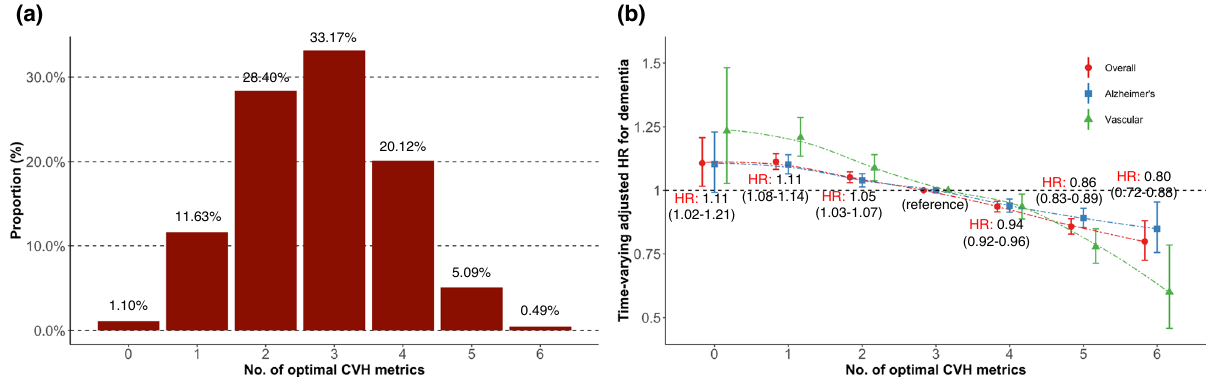
Figure 2. Plots of time-varying HRs for the association of the number of optimal CVH metrics with the risk of dementia. ( A ) The proportion of participants according to the number of optimal CVH metrics. ( B ) Time-varying HRs plot according to the number of optimal CVH metrics. Stroke censoring was performed in the analysis. Time-varying HRs were estimated using the group with the median optimal metrics of 3 as the reference groups. All multivariable time-varying Cox regression models were adjusted for age, sex, economic status, living area, comorbidities (AF, HF, MI, coronary heart disease, PAD, anemia, CKD, hyperthyroidism, hypothyroidism, osteoporosis, sleep apnea, COPD, chronic liver disease, and cancer), medications (oral anticoagulants, antiplatelet agents), depressive mood, lower extremity function, and cognitive function at baseline. Each type of dots with interval bars indicates time-varying multivariable-adjusted HRs and 95% CIs (exact values of HR with 95% CI on overall dementia only are displayed above or below each interval bar). Two-dashed lines indicate the trend of changes in HRs according to the number of optimal CVH metrics. Abbreviations: AF atrial fibrillation, CI confidence interval, CKD chronic kidney disease, COPD